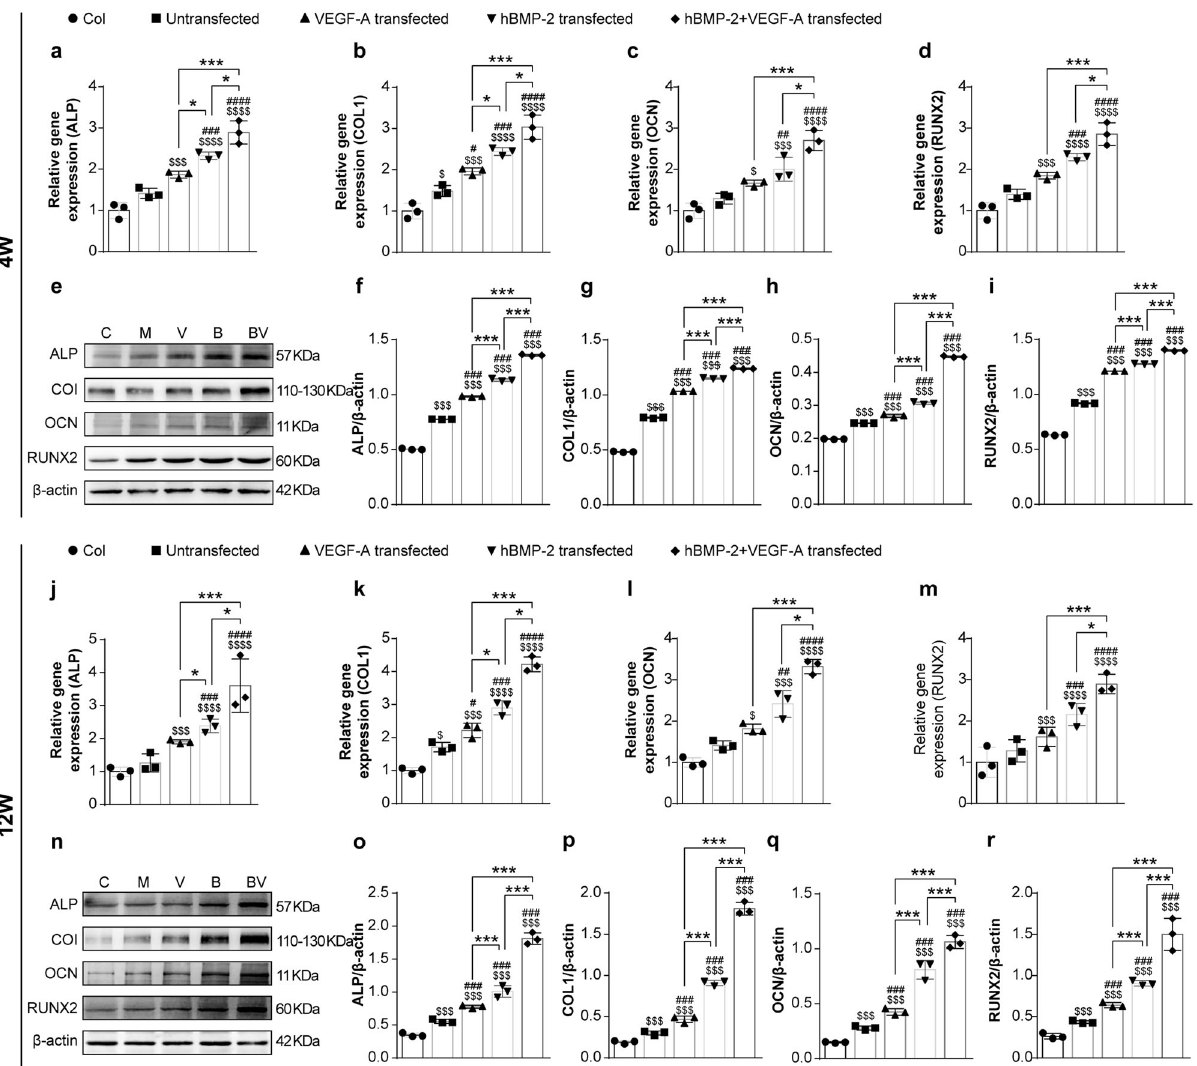
Fig. 6 Transcriptional and translational expression patterns of osteogenic genes in regenerating bone ex vivo. Osteogenic related gene expression of ALP, COL1, OCN, and RunX2 were analyzed using qRT-PCR at 4 wks ( a – d ) and 12 wks ( j – m ) post-implantation. Protein expression of ALP, COL1, OCN, and RunX2 were analyzed using Western blot analysis in untreated and treated groups at 4 wks ( e – i ) and 12 wks ( n – r ) post-treatment. Dollar ($) indicate difference between acellular collagen scaffold group and treatment groups. Hash (#) indicate difference between non-transfection and transfection groups. Asterisk (*) indicate difference among different modRNA transfection groups. Results for qRT-PCR are normalized to the housekeeping gene (rat GAPDH) and to the empty group, and for western blot, the housekeeping protein is rat β -actin. Values are shown as mean ± SD, $/#/ * p < 0.05, $$/##/ ** p < 0.01, $$$/###/ *** p < 0.001. N = 6, One-way ANOVA followed by Tukey ’ s multiple